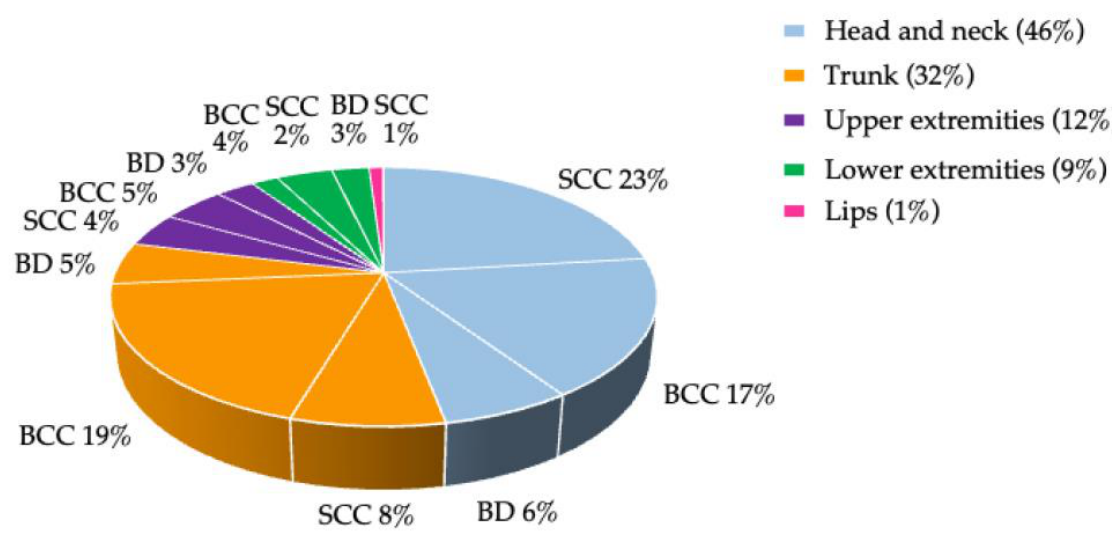
Figure 1. Anatomical localization of NMSC subtypes.